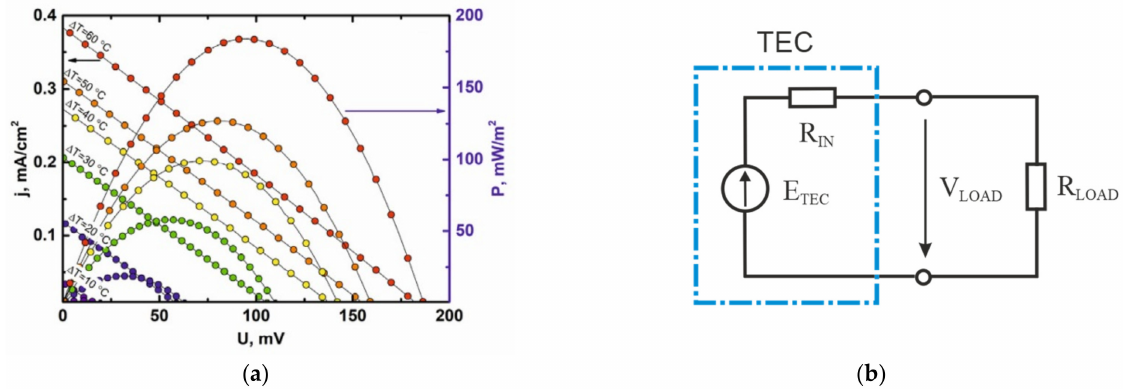
Figure 4. ( a ) Voltage output and the corresponding power output of TEC [31]; ( b ) electrical model of